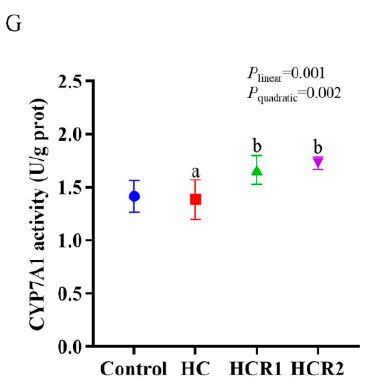
Figure 8. Protein levels of Srebp2 ( A ), Hmgcr ( B ), Ldlr ( C ), Fxr α ( D ), Lxr α ( E ), and Cyp7a1 ( F ) as well as the CYP7A1 ( G ) activity in the liver. Each data point represents the mean of four replicates (4 individuals per replicate). * Means p < 0.05, compared between the control and the HC group. ab Compared among the HC, HCR1, and HCR2 groups. Bars assigned with different superscripts are significantly different ( p < 0.05). Control, diet with 32% nitrogen-free extract; HC, diet with 45% nitrogen-free extract; HCR1, diet with 45% nitrogen-free extract and 0.04% resveratrol; HCR2, diet with 45% nitrogen-free extract and 0.08% resveratrol. Srebp2, sterol regulatory element-binding protein 2; Hmgcr, 3-hydroxy-3-methyl-glutaryl coenzyme A reductase; Ldlr, low-density lipoproteins receptor; Fxr α , farnesoid X receptor α ; Lxr α , liver X receptor; Cyp7a1, cholesterol 7 α